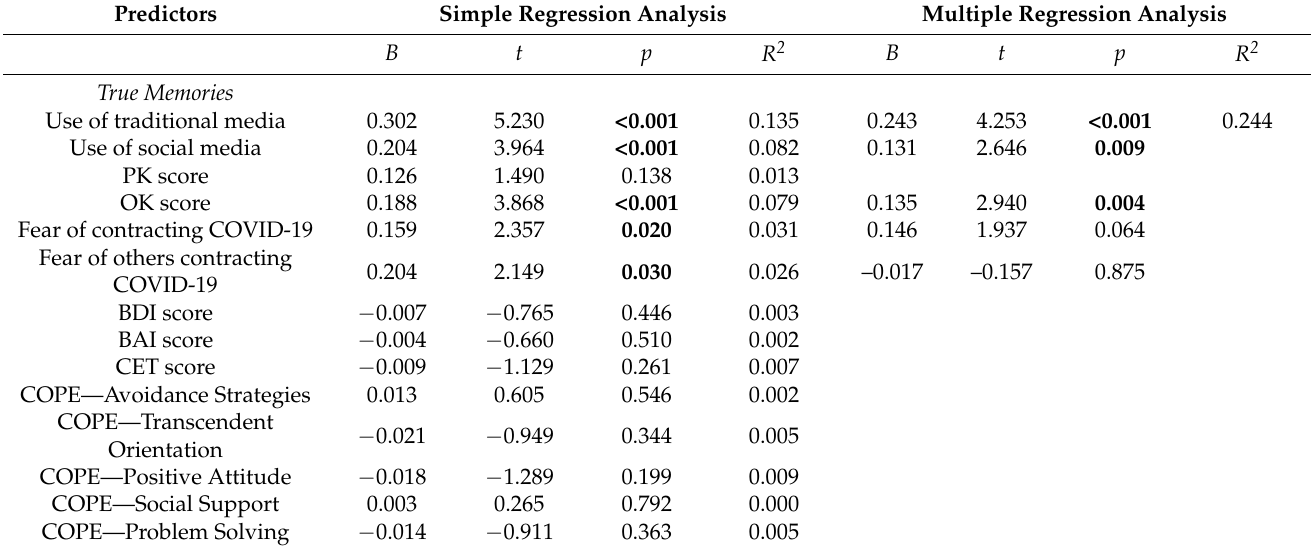
Table 3. Results of simple and multiple regression